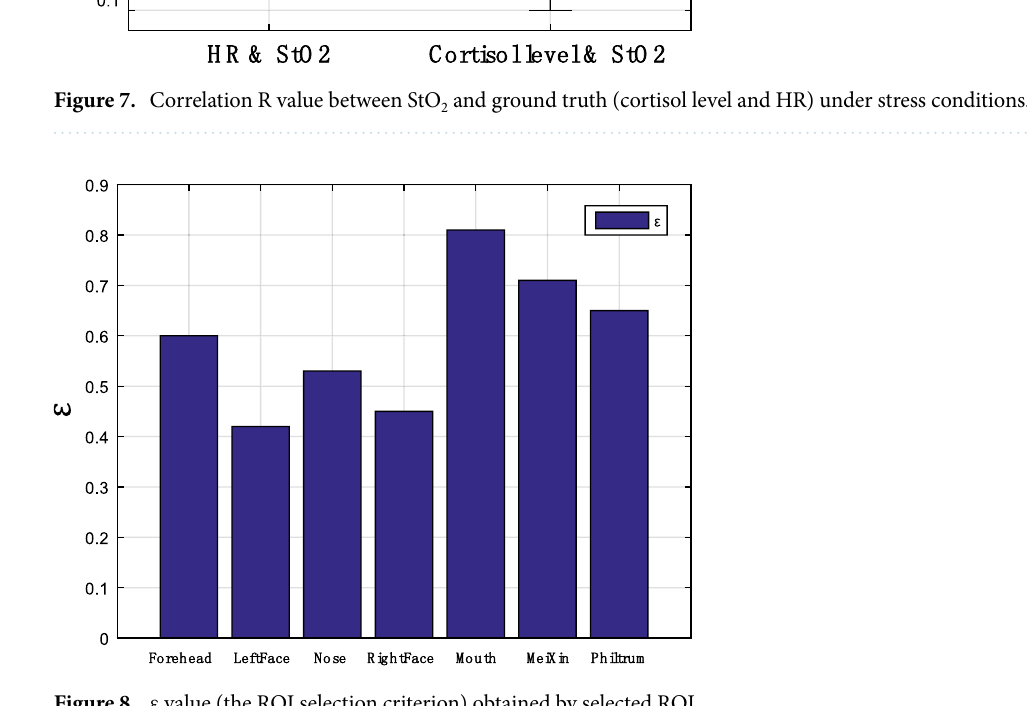
Figure 8. ε value (the ROI selection criterion) obtained by selected